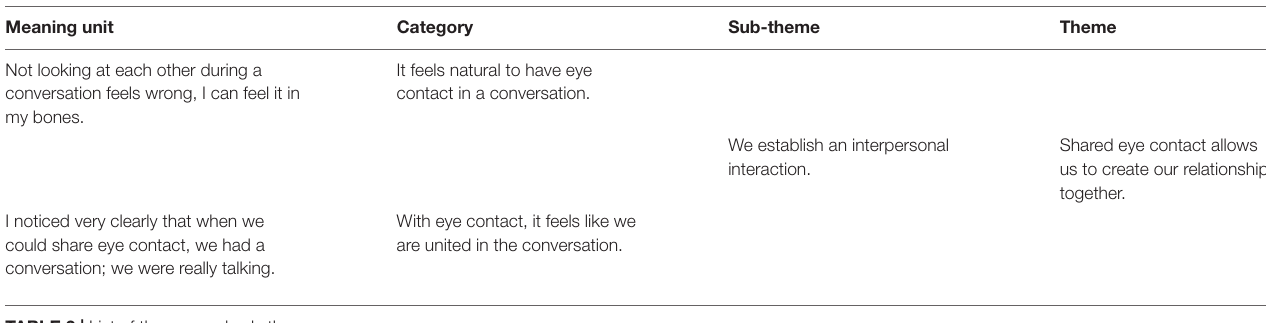
TABLE 2 | List of themes and